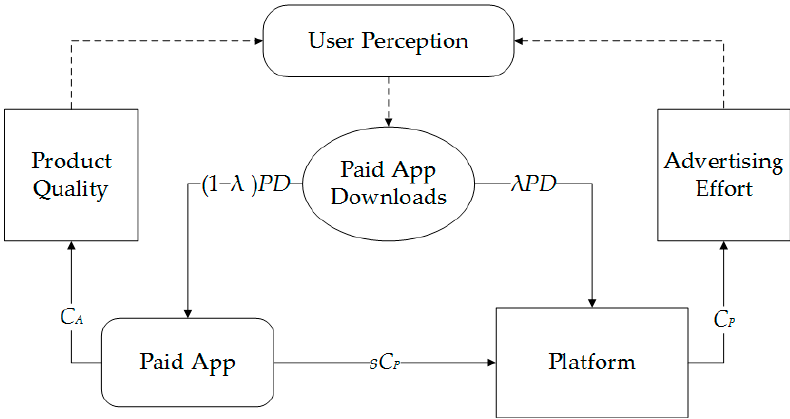
Figure 2. The interaction between the paid App, the platform, and the users.